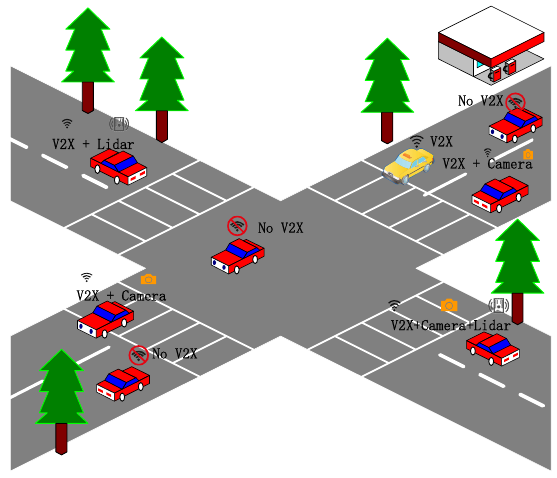
Figure 9. Illustration of the cooperative perception conception. Table 6. Summary of the existing research on cooperative perception information-sharing communi- cation technology according to market penetration rate and vehicle